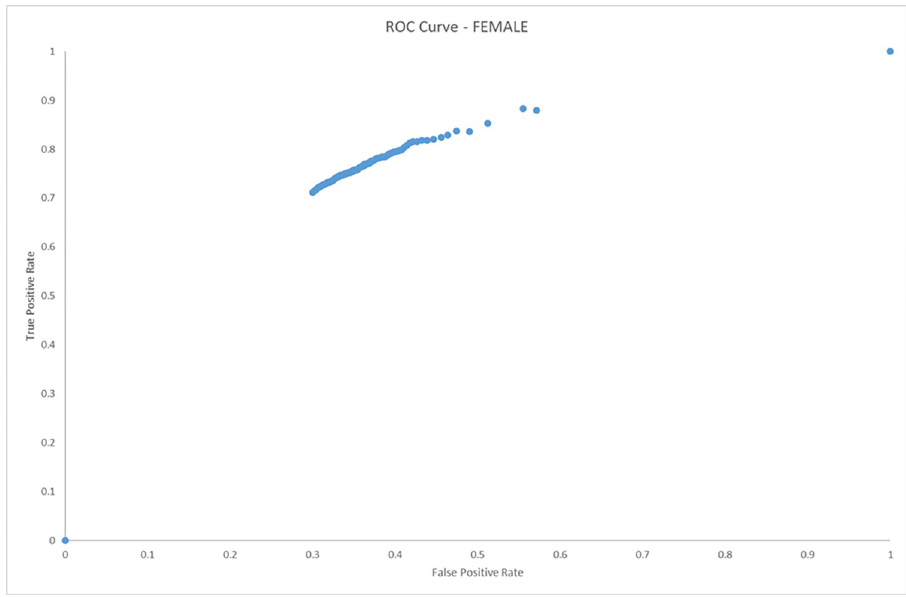
Fig 5. ROC curve (female only). AUC (area under curve) =